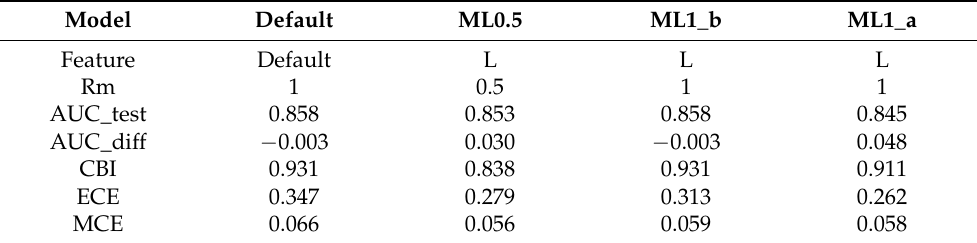
Table 1. Performance assessment comparison of Maxent models with default setting and the op- timized model parameter values, namely ML0.5 and ML1. ML1_a is the ML1 model before bias correction and ML1_b is the chosen optimized model with sampling bias